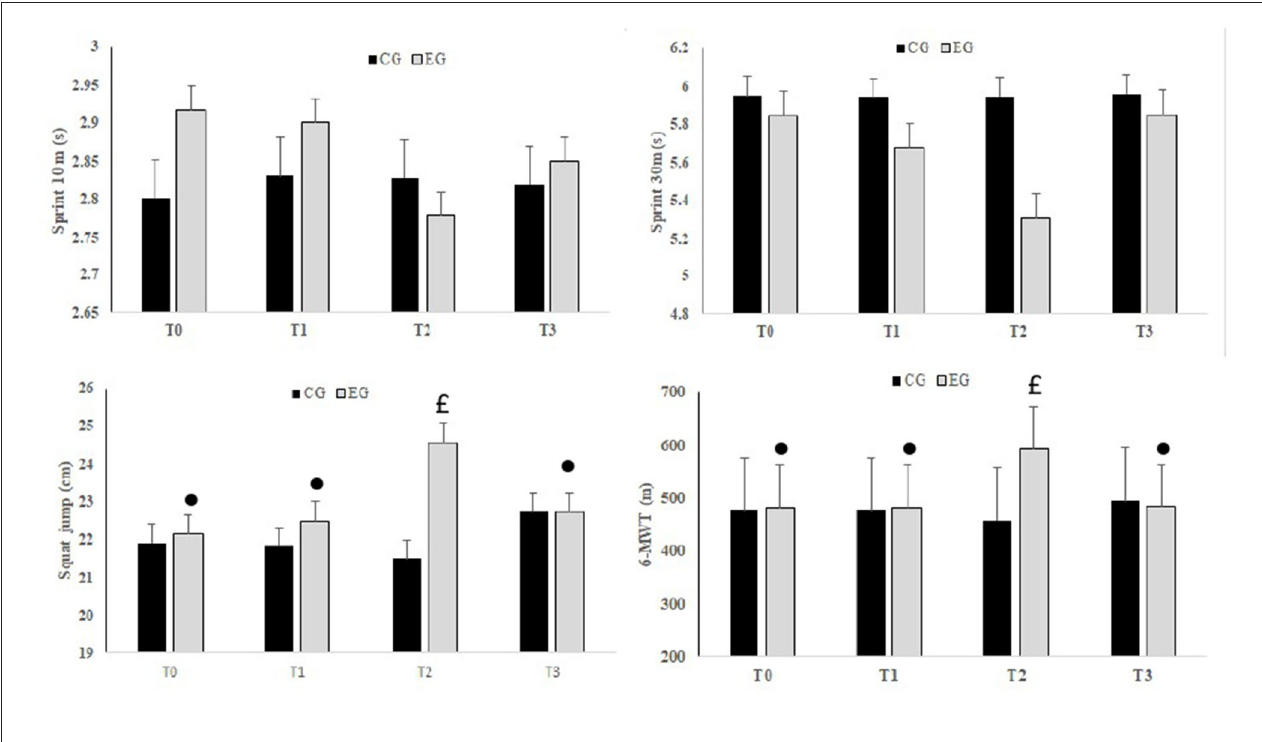
FIGURE 3 | Mean values ± standard deviation (SD) for 10 and 30m Sprint, Squad Jump and the 6min walking test (6MWT) registered before Ramadan (T0), in the second week of Ramadan (T1), in the fourth week of Ramadan (T2) and after Ramadan (T3) in the CG and EG. •, Significant difference compared to T2; £, Significant difference compared to CG.